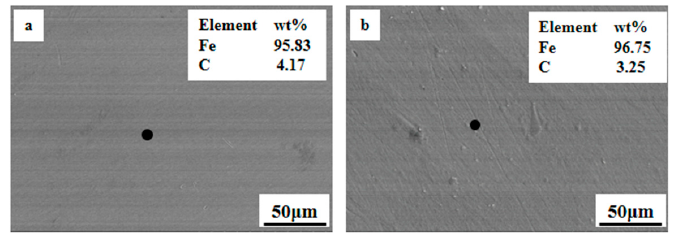
Metals 2019 , 9 , 510 Figure 18. SEM image of dripping iron for sinter with ( a ) low MgO and ( b ) high MgO.